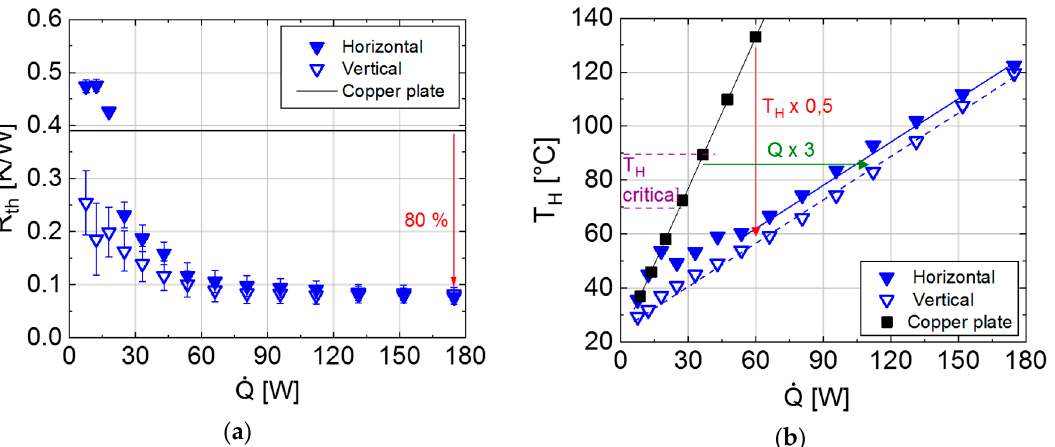
Figure 4. Results for PHPs with channel size of 1 × 1 mm 2 with water cooling for horizontal and vertical orientation, compared to a solid analogous copper plate (i.e., with the same dimensions) for heating powers up to 180 W. ( a ) Plot of thermal resistance R th vs. heating power ´ Q . Red arrow: reduction in R th compared to copper plate; ( b ) plot of heater temperature T H vs. heating power ´ Q . Red arrow: heater temperature of heater on PHP relative to copper plate at the same heating power. Red number: ratio of T H on PHP vs. copper plate in ◦ C. Green arrow: heating power of heater on PHP relative to copper plate at the same temperature of ca. 80–90 ◦ C, which is a critical temperature not to be exceeded for many electronic parts. Green number: ratio of allowed power on PHP vs. copper plate for “critical temperature”.